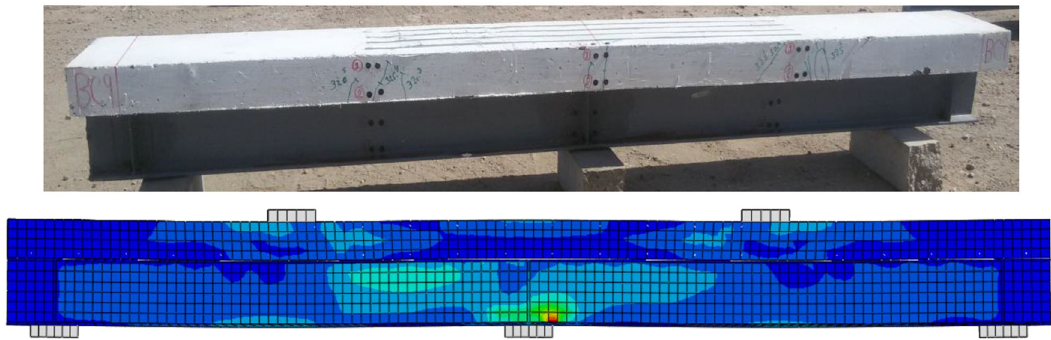
Figure 8: Comparison between the experimental and numerical stress distribution at failure for the sample ( BC2 ) [ 31 ] .